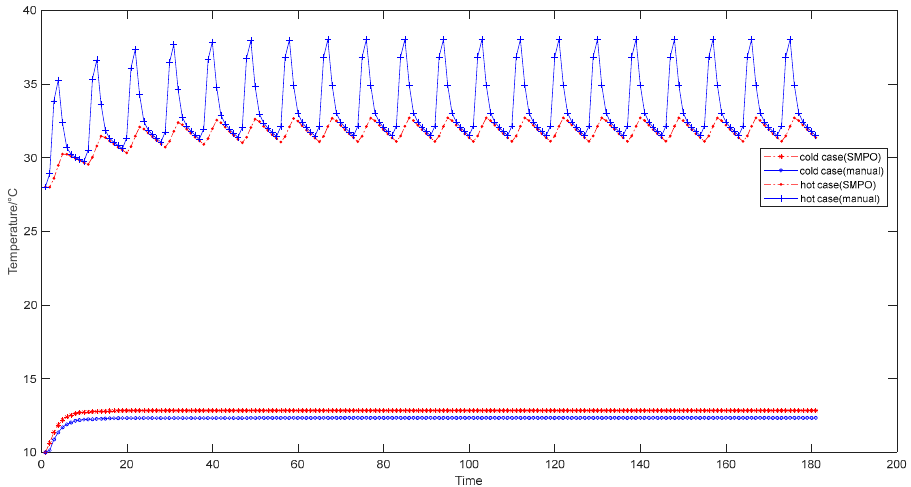
Figure 14. Comparison of the performance of parameter optimization in high- and low-temperature cases.